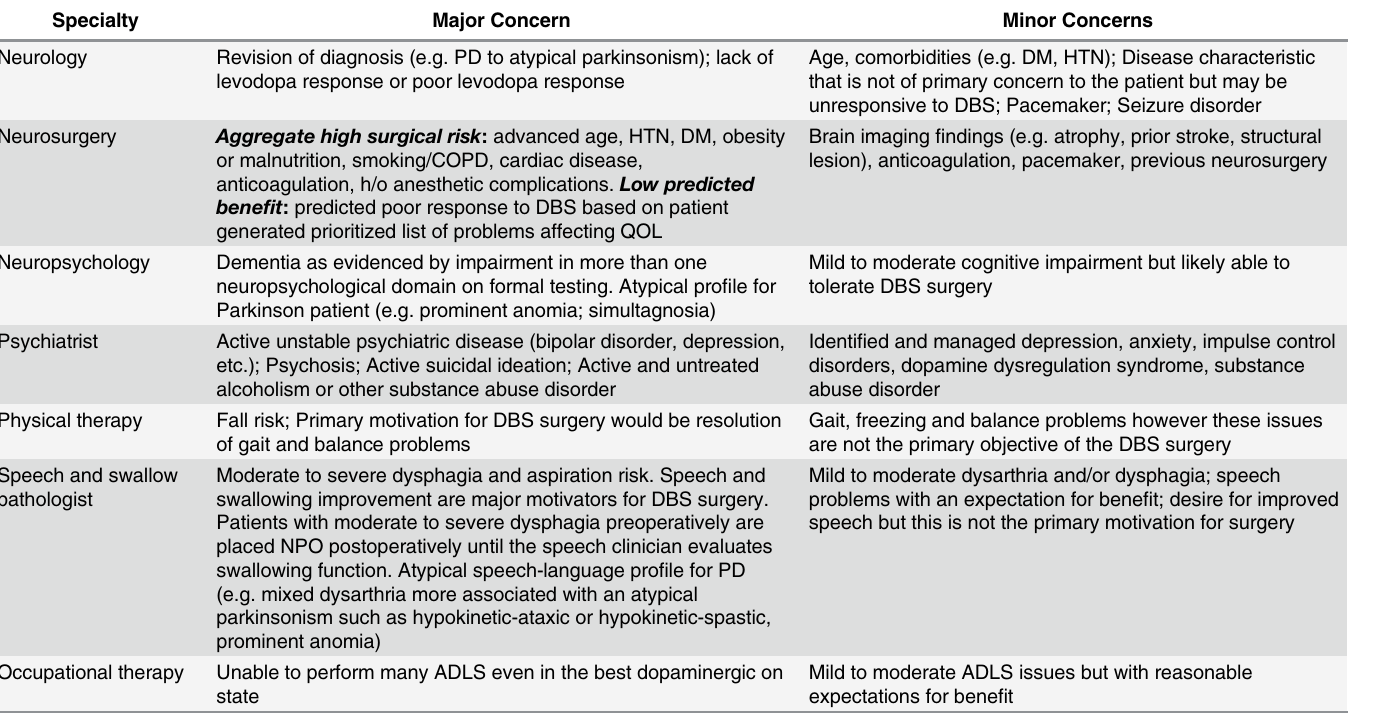
Table 1. Examples of concerns raised by specialties during discussion of DBS